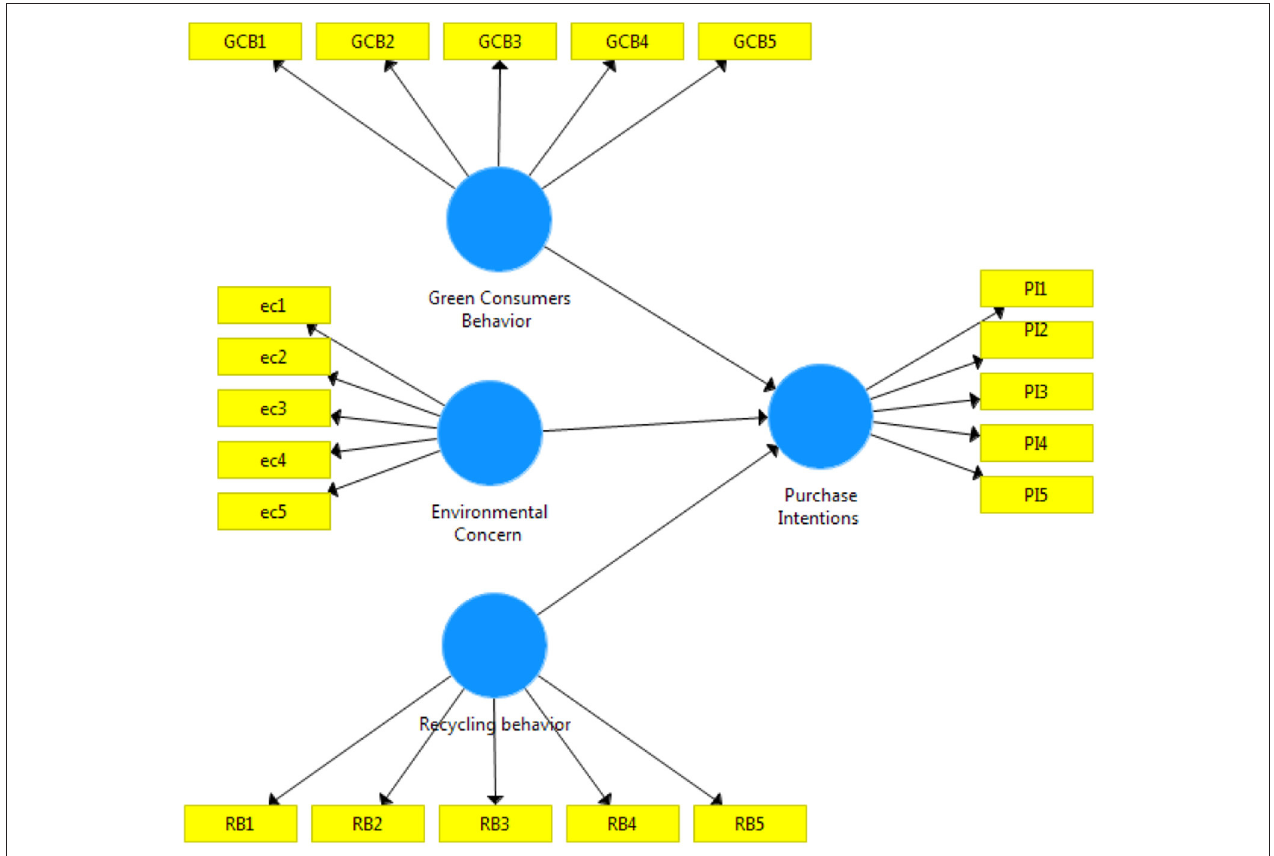
FIGURE 1 | Conceptual